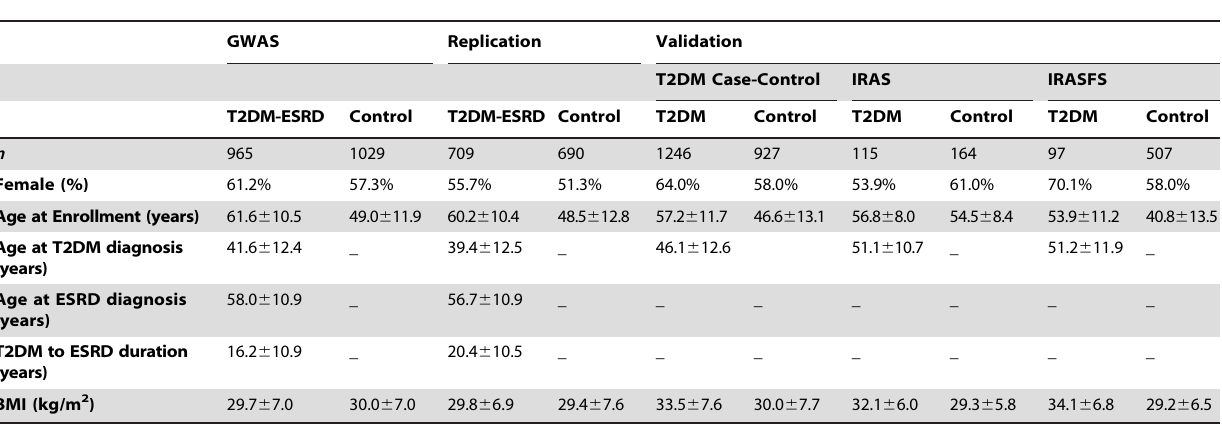
Table 1. Clinical Characteristics of Study